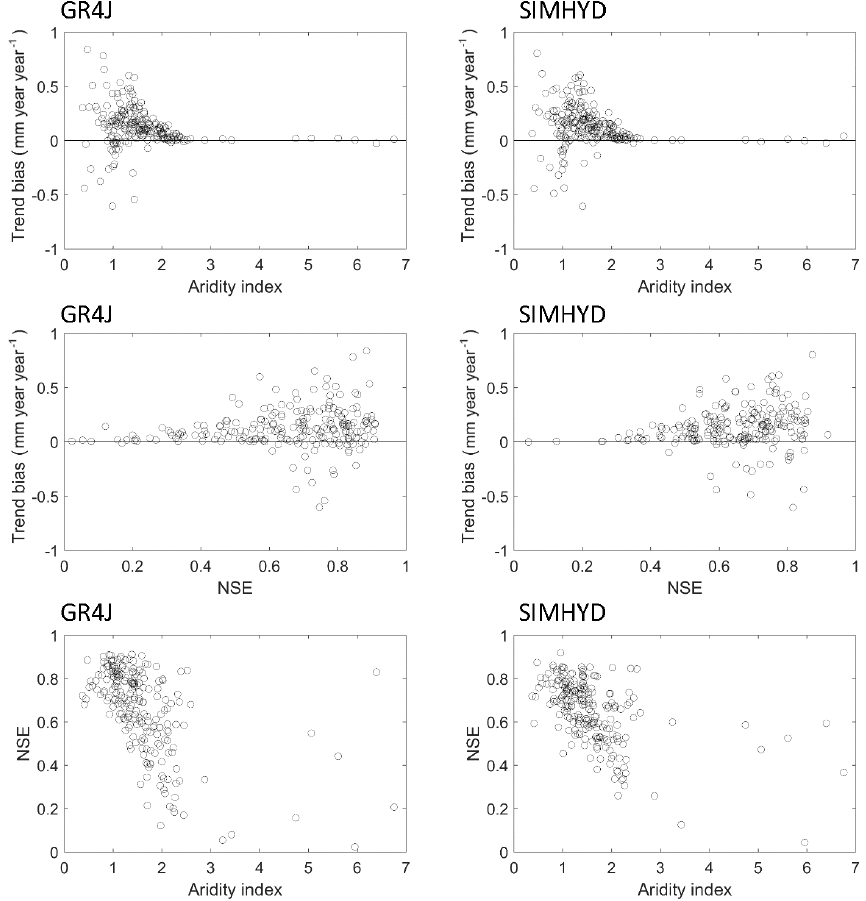
Figure 10. Relationships among trend bias (mmyear − 1 year − 1 ), model calibration Nash–Sutcliffe efficiency and aridity index for each catchment and for the experiment of the 10% missing data rate.